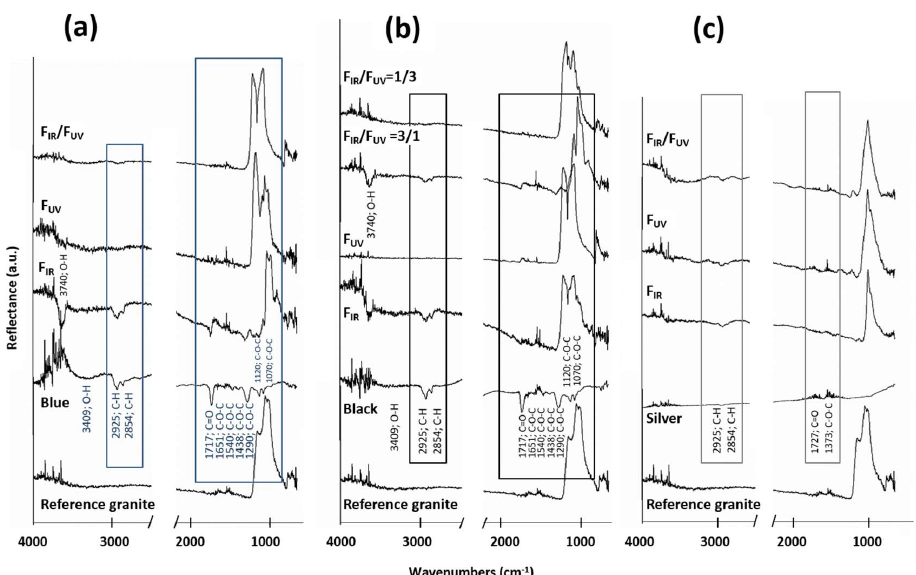
Figure 5. Fourier transform infrared (FTIR) spectra (reflectance mode) of the surfaces irradiated with the selected conditions with 1064 nm (IR), 355 nm (UV) and their simultaneous use (in various F IR / F UV ratios) to remove blue ( a ); black ( b ) and silver ( c ) graffiti paints. FTIR spectra of the reference granite and the graffiti paints are also shown for comparative purposes. Detailed information on fluence values and pulses for each irradiation condition can be found in Table 2.